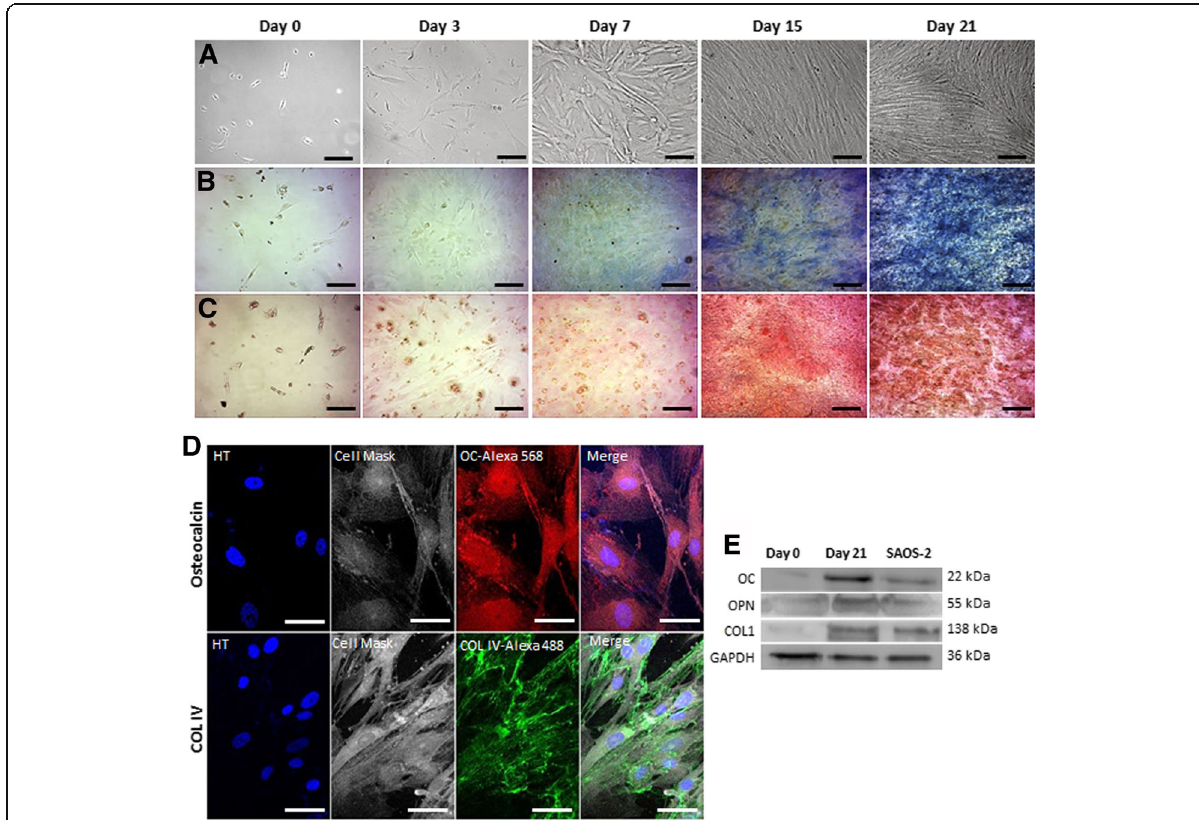
of osteogenic differentiation. b ALP activity observed with optic microscopy at days 0, 3, 7, 15 and 21 by an ALP staining ( blue ). c Images of mineralitzation at days 0, 3, 7, 15 and 21 stained by the von Kossa method showing mineralized bone ( brown ) and osteoid, supporting tissue and structures ( red ). d , e Osteogenic protein expression of DPPSC after 21 days. d Immunofluorescence analysis of DPPSC showing the expression of Osteogenic markers at day 21 of differentiation. Hoechst (HT) as a nucleus control. Scale bars: 200 μ m ( a - c ), 50 μ m ( d ). e Western Blot analysis of osteogenic markers at day 0 and 21 of differentiation. SAOS-2 cells were used as a positive control. GAPDH was used as a housekeeping